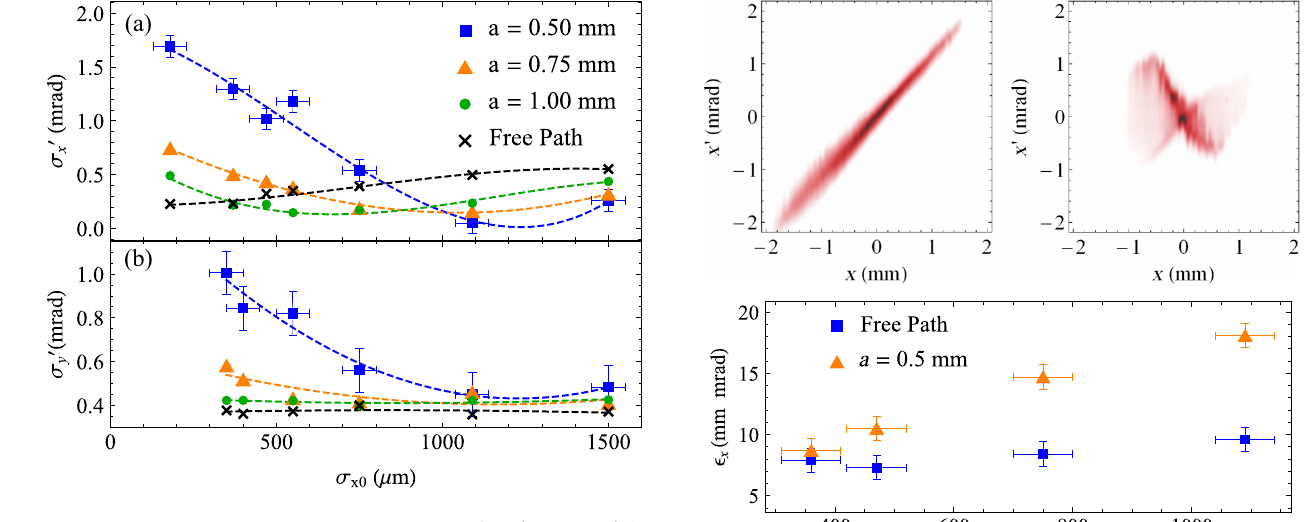
FIG. 4. Beam divergence calculated as σ 0 ¼ ð σ S 5 − σ S 4 Þ =L where L ¼ 2 . 05 m is the distance between screens in horizontal (a) and vertical (b) planes. Dashed lines are third order poly- nomial fits to aid legibility. Measurements are presented for structure half-gaps of a ¼ 0 . 5 , 0.75, and 1.0 mm. The beam is set on axis of the structure at each gap and the bunch length is σ ¼ 800 fs. Error bars shown for a ¼ 0 . 5 mm data are repre- t sentative of errors for other half-gaps, which are omitted to aid legibility.